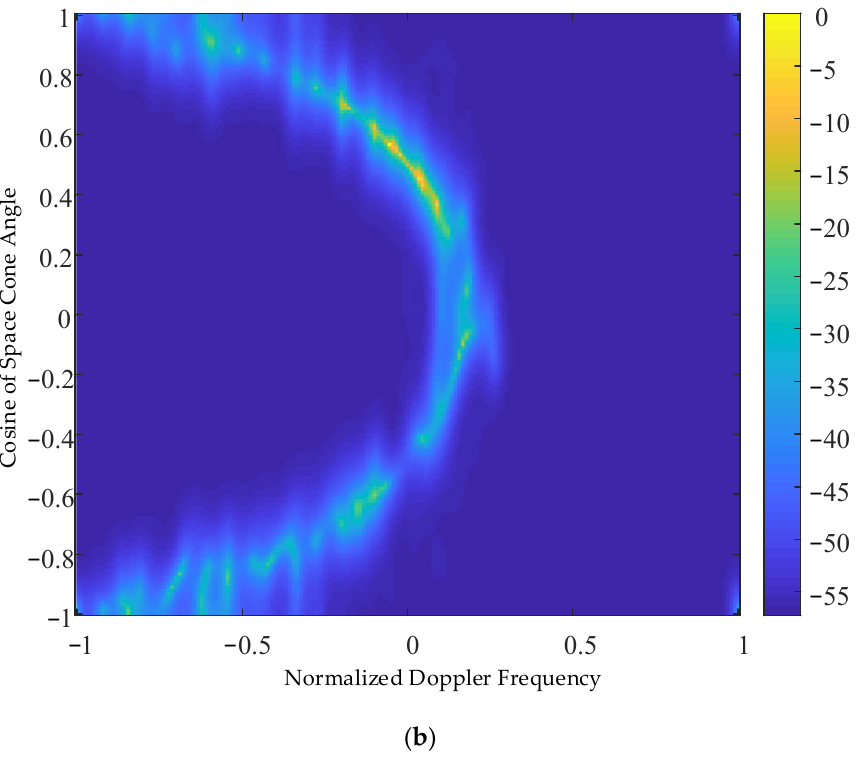
Figure 6. Space–time two-dimensional spectrum of ground clutter recovered by KASPICE-STAP method and DDD-SR-STAP method. ( a ) KASPICE-STAP method. ( b ) DDD-SR-STAP method. Figure 7 shows the clutter characteristic spectra of the clutter covariance matrix esti- mated by the KASPICE-STAP method, the DDD-STAP method, and the DDD-SR-STAP method. It can be seen from Figure 7 that the number of large eigenvalues of the clutter covariance matrix estimated by the KASPICE-STAP method is smaller than that of the other two methods, that is, the clutter degree of freedom is low, so the clutter covariance matrix estimated by the KASPICE-STAP method is more accurate.